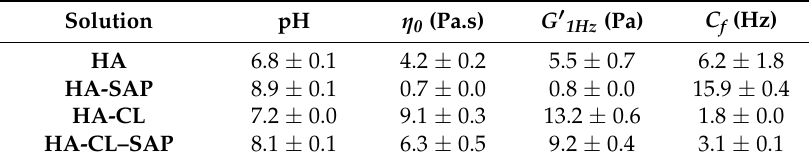
Table 1. Main properties of HA solutions: pH, η 0 , G (cid:48) 1Hz , C f ( n = 3, ± SD).